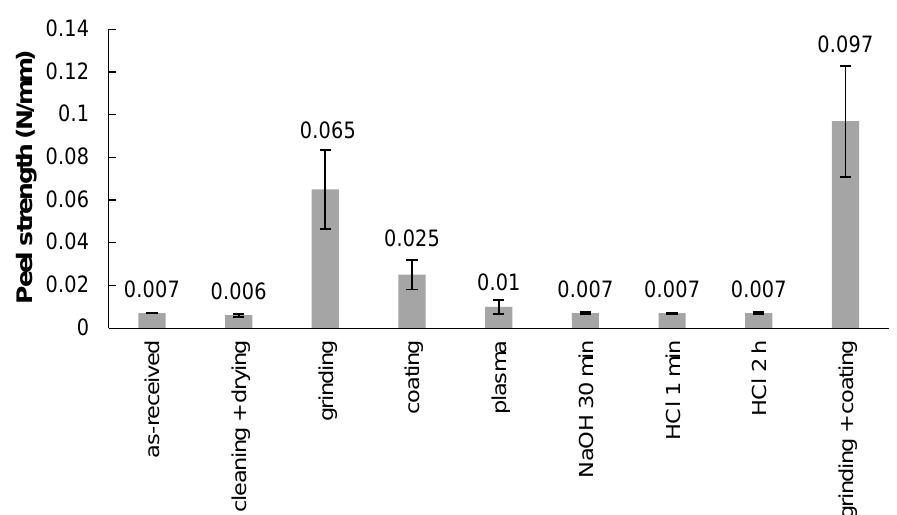
Figure 3. The peel strength of the bilayer samples.